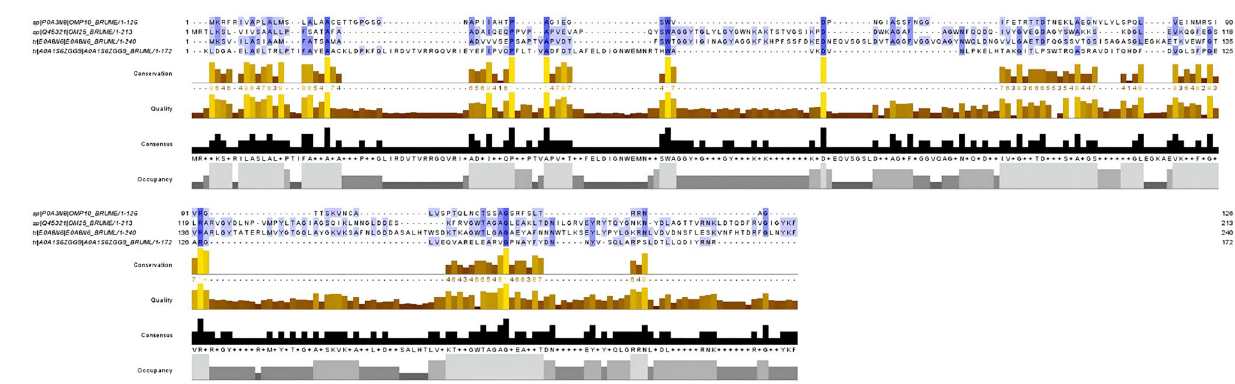
Figure 2. The homologous sequence comparison of the proteins. The black area in the figure is the highly conserved amino acid region, while the blue part is the similar amino acid sequence